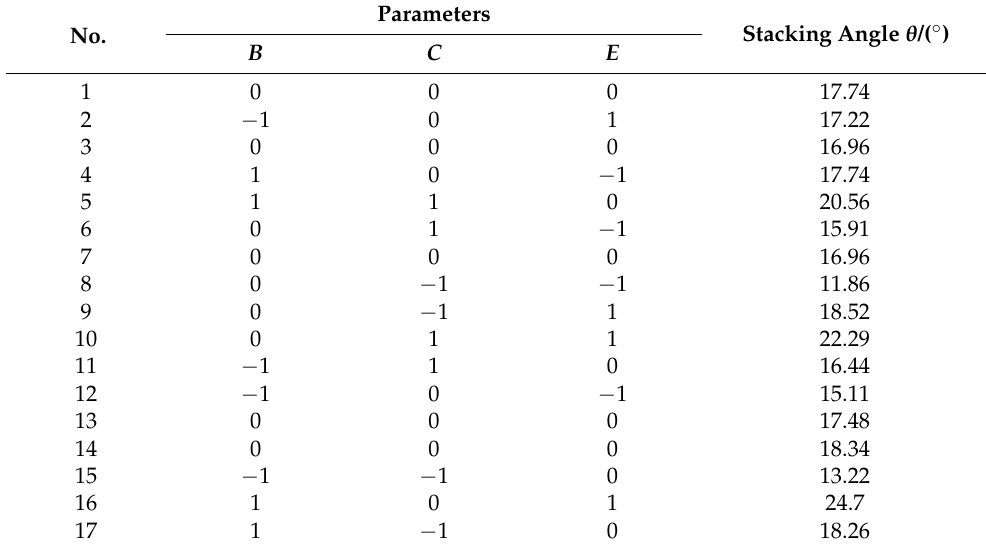
Table 6. Box–Behnken test